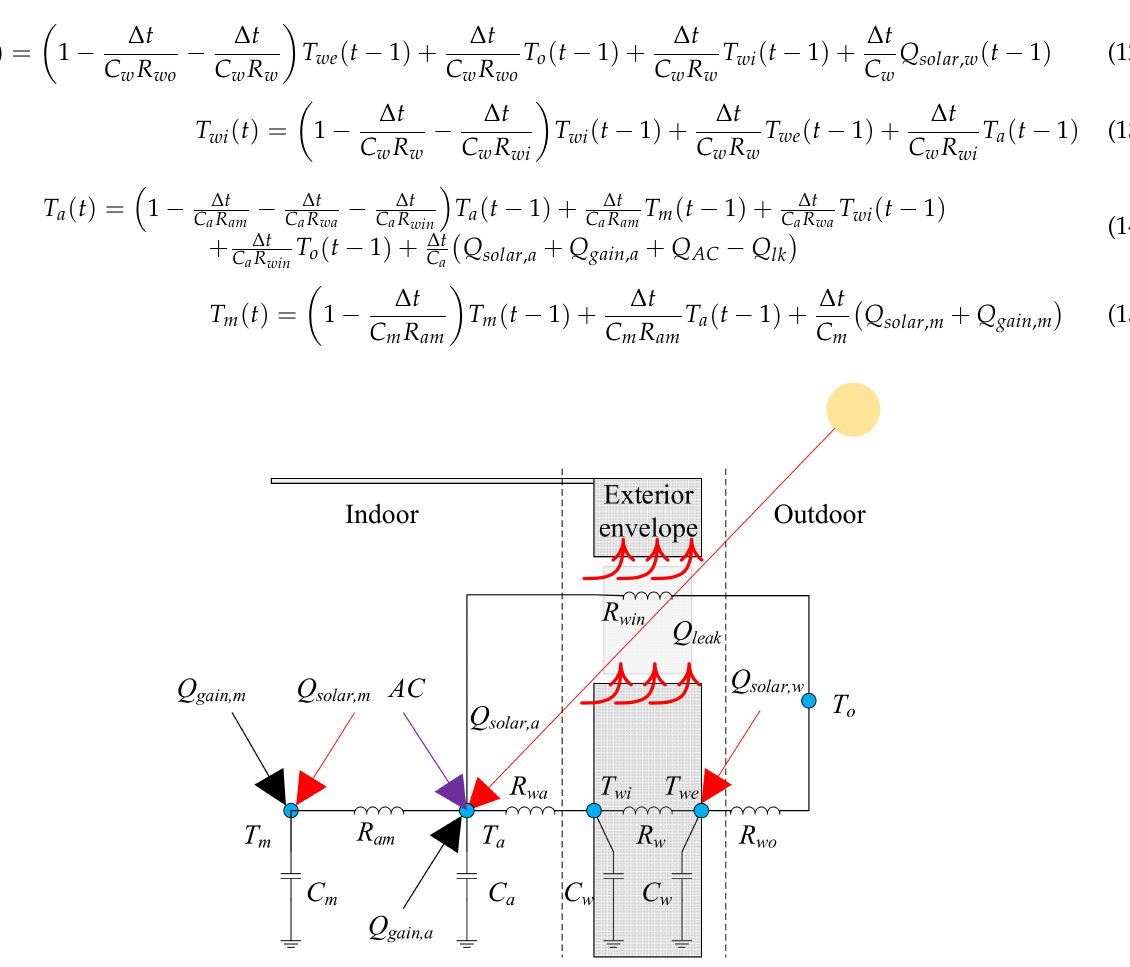
Figure 2. ETP model of